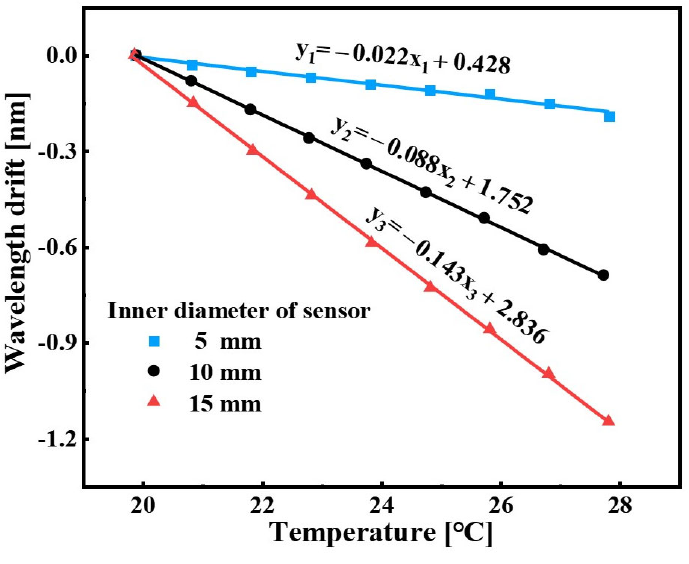
Figure 7. Temperature effect on the sensor.